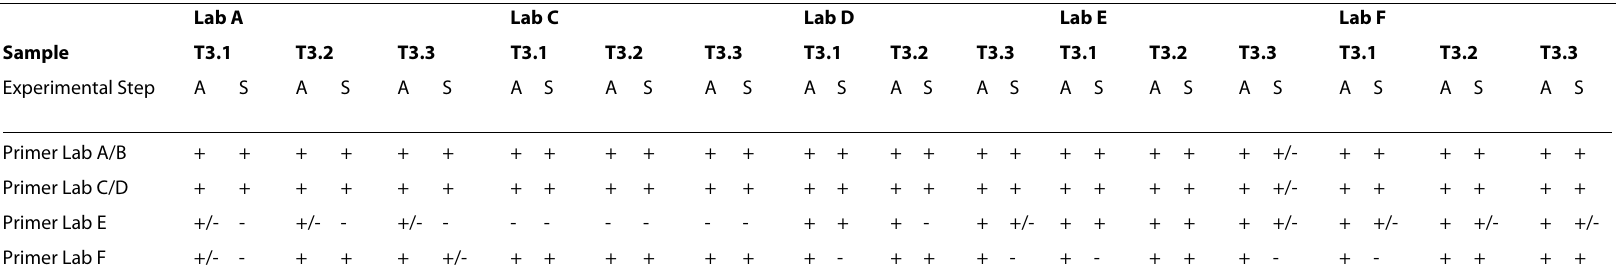
For each lab the result of amplification (A) and sequence analysis (S) is detailed. "+" means success of amplification or nominal result in sequence analysis, "+/-" means only faint amplification with unspecific extra-bands or different/not-scorable sequence-analysis, and "-" means failure of amplification or sequence analysis. Primer pairs used in Lab A and B and Lab C and D were the same, respectively. Lab B did not participate in the third trial